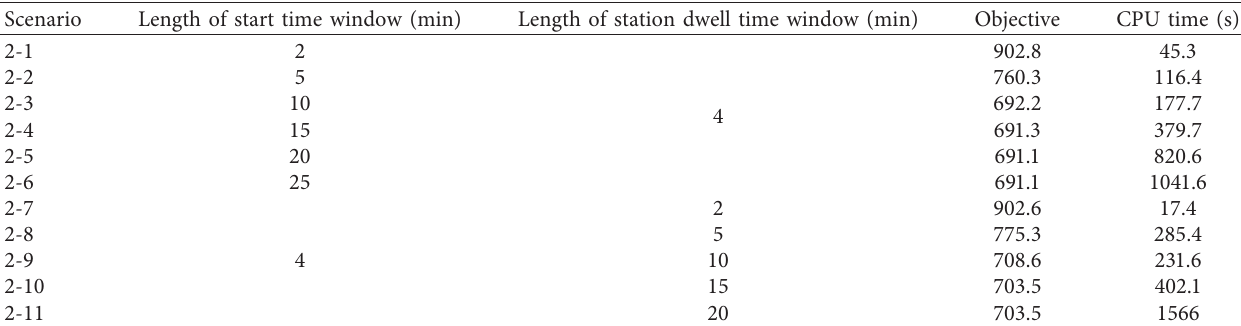
Table 6: Performance comparison with an increase in the number of train paths.